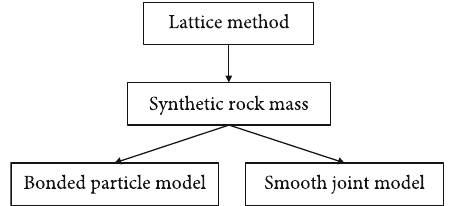
Figure 2: Schematic diagram of lattice simulation